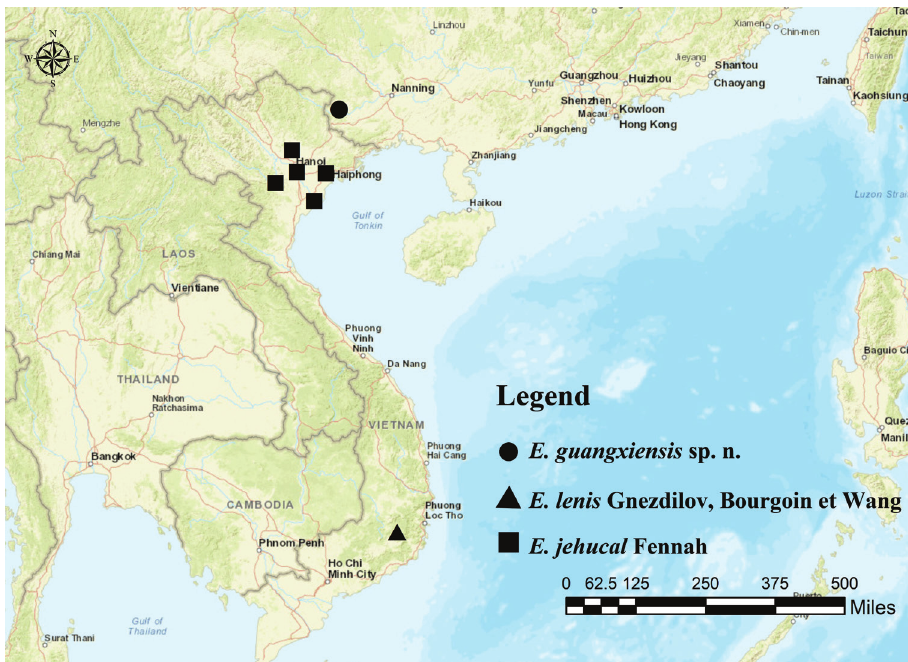
Figure 21. Geographic distribution of Euxaldar